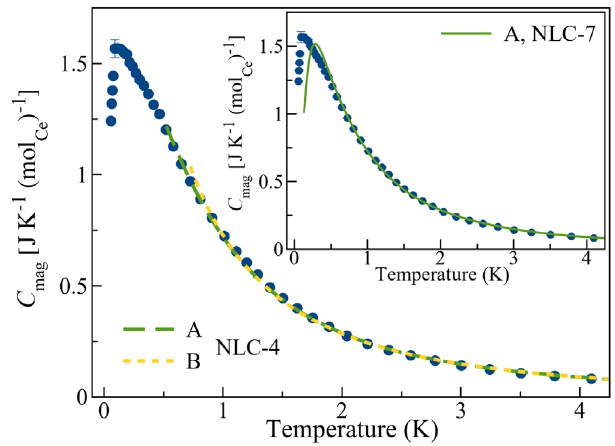
FIG. 6. The results of the fourth-order NLC C calculation mag for zero sample oxidation, using the near-neighbor exchange 0 . 064 meV, J 0 . 063 meV, J 0 . 011 meV parameters J a ¼ b ¼ c ¼ 0 . 089 meV, J − 0 . 007 meV, J (set A) and J a ¼ b ¼ c ¼ − 0 . 027 meV (set B), overlaid on top of the measured C for mag our Ce 2 Zr 2 O 7 sample. The inset shows the results of the seventh- order NLC C calculation for zero sample oxidation, using the mag set A near-neighbor exchange